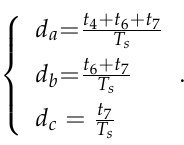
Figure 2. ( a ) The space vector of the PMSM drive. ( b ) The vector composition in sector I. From (2), the duty cycles of the PWM signals can be deduced as